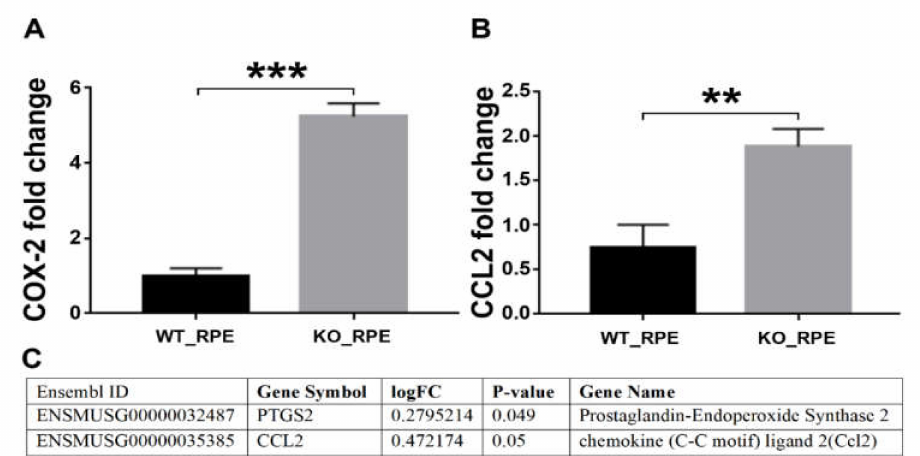
Figure 6. Quantitative RT-PCR analysis of ( A ) Prostaglandin-Endoperoxide Synthase 2 ( COX-2 ) and ( B ) chemokine ligand 2 ( CCL2 ) in WT and CXCR5 -deficient RPE (n = 3). The Student’s t-test was used to determine statistical significance between the two groups. ** p < 0.05; *** p < 0.01. ( C ) RNA-seq values of logFC and p -value for COX-2 and CCL2 . The positive logFC values indicate up-regulated genes, and negative values indicate down-regulated genes in CXCR5 -deficient RPE cells relative to WT